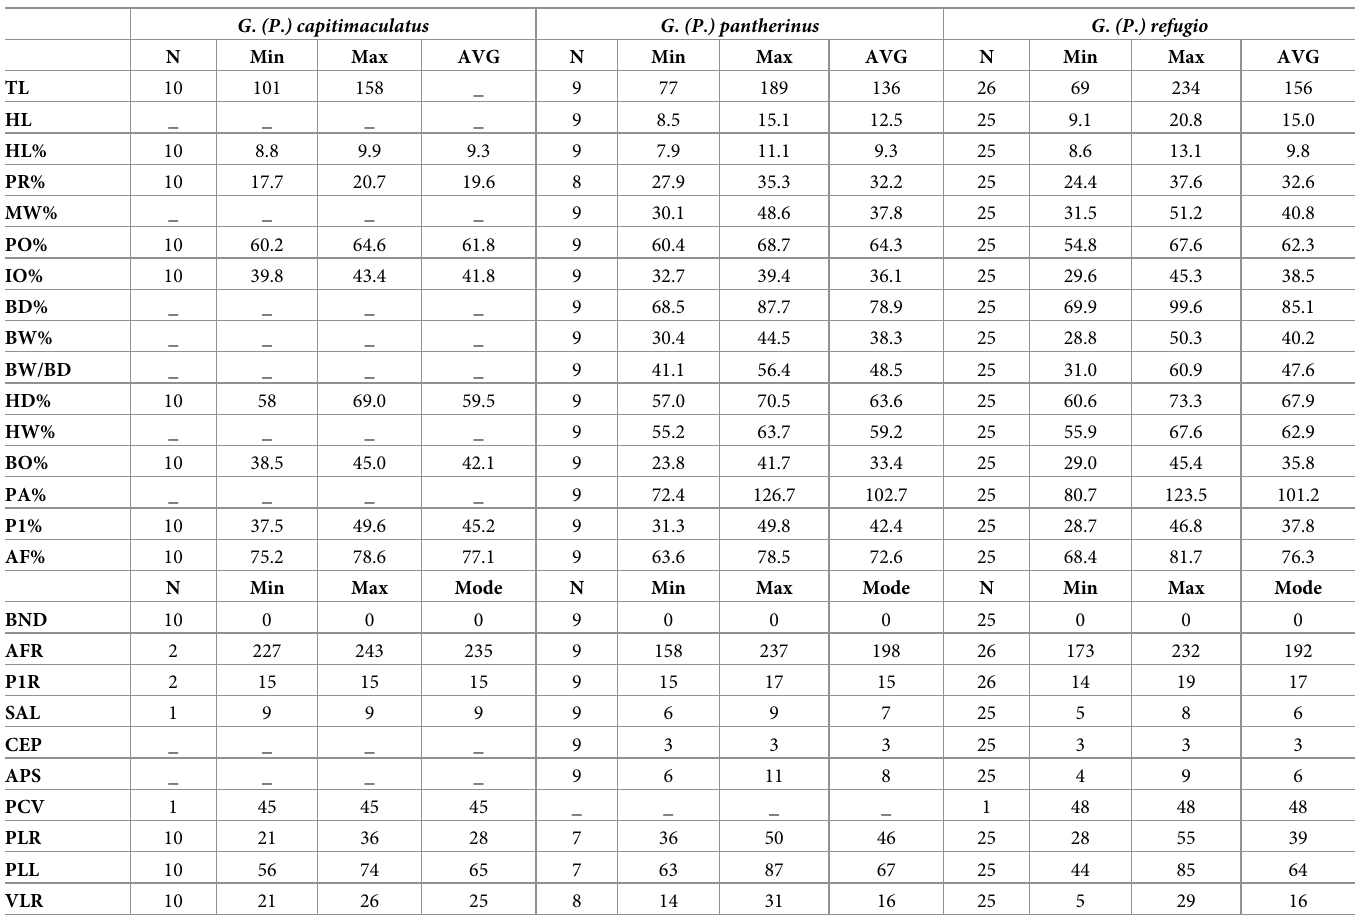
Table 14. Summary of morphometric and meristic data for three species of Pantherus . Data for a total of 35 specimens. G . (P . )